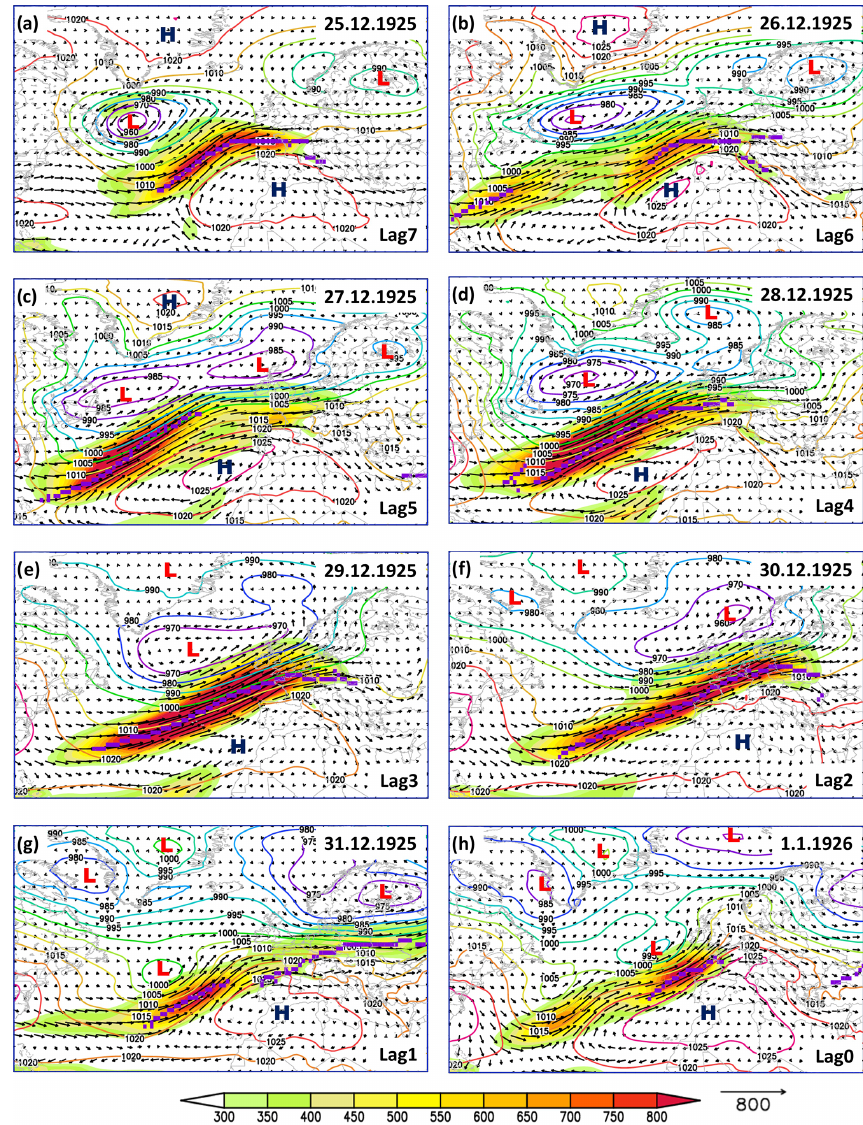
Figure 3. Daily sea level pressure (SLP; colored contour lines), magnitude of the integrated water vapor transport (IVT; shading), direction of the integrated water vapor transport (vectors) and location of the AR axis (magenta line) for different time lags (0–7d) for the 1925– 1926 flood event. Units: SLP (hPa) and IVT (kgs − 1 m − 1